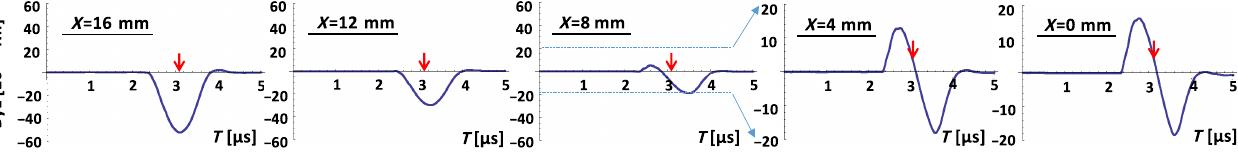
FIG. 3. PSM2 magnetic-field shape at each position in the magnet gap along the horizontal axis with the ceramic chamber. The red arrows show the timing of the kicking of the injected beam. The vertical axes for x ¼ 4 mm and x ¼ 0 mm are magnified by a factor of 3.